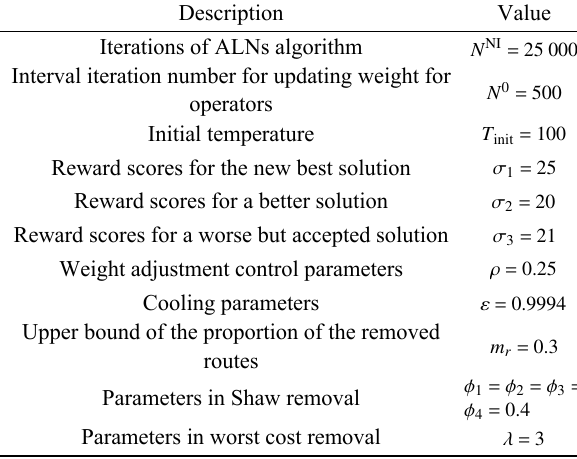
Table 2 Algorithm parameters to be tuned and